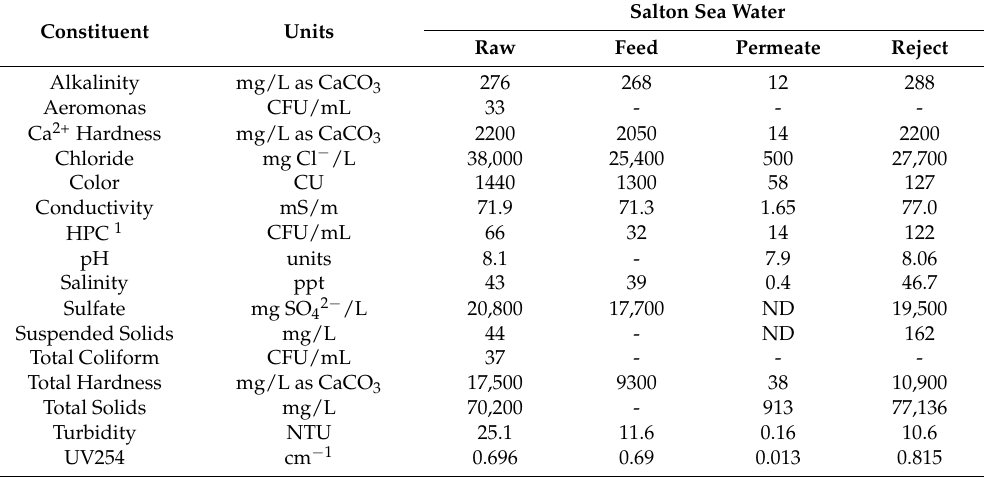
Table 4. Salton Sea Water Analytical Results 1